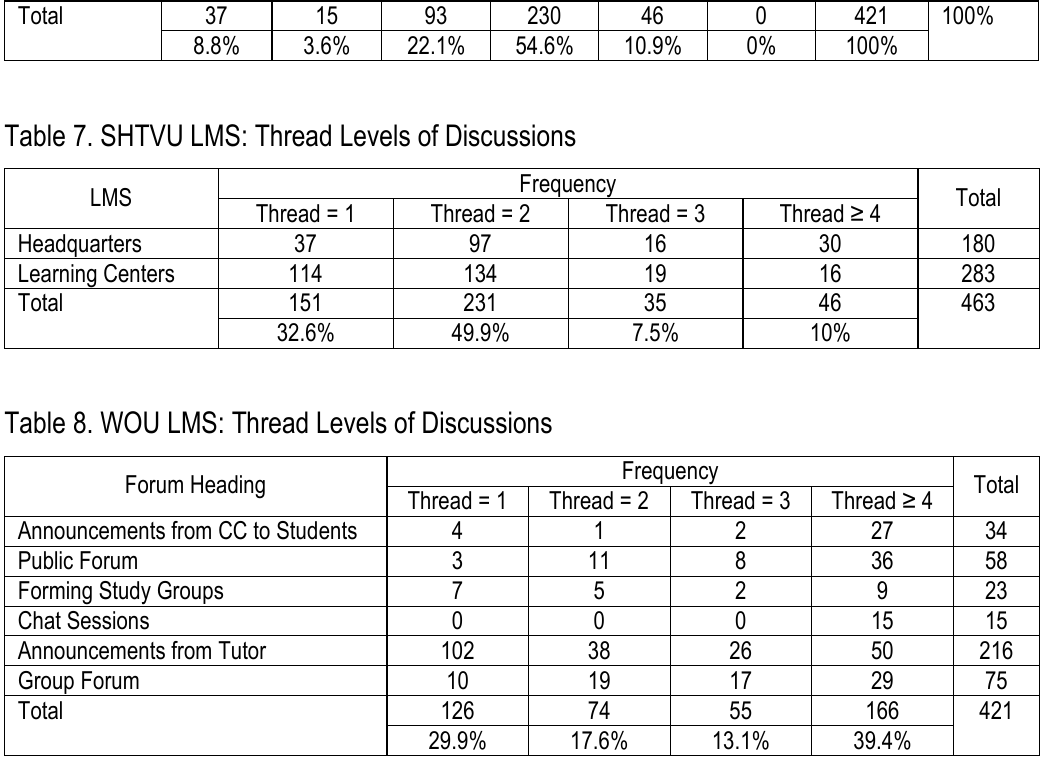
Table 6. WOU LMS: Number and Types of Interactions Dimension Cognitive Procedural